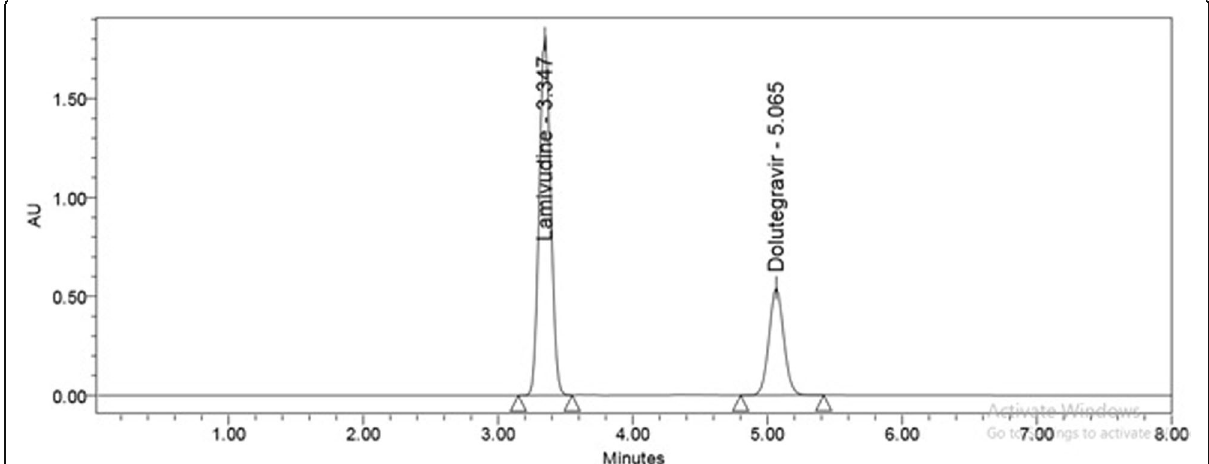
Fig. 2 Optimized chromatogram of the method